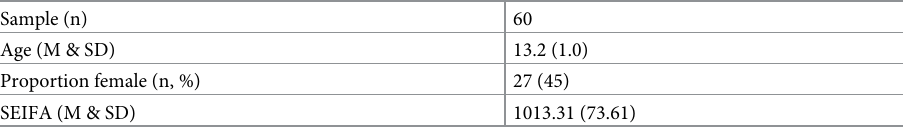
Table 2. Descriptive statistics of study